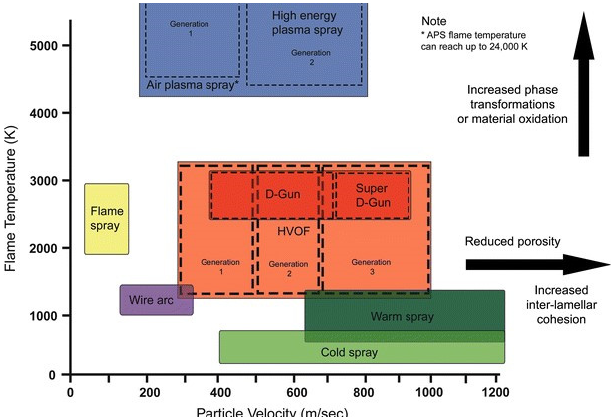
Figure 2. Temperature and velocity profiles of thermal and cold spray technologies. Reprinted with permission from [23] Copyright 2021 Springer .